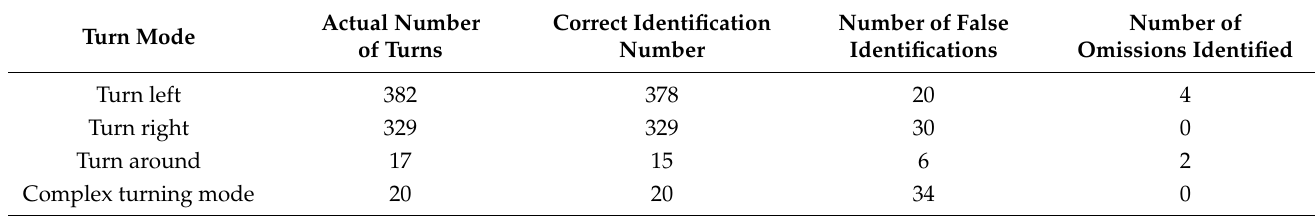
Table 8. Recognition accuracy of turning modes when the compression threshold is set to 5